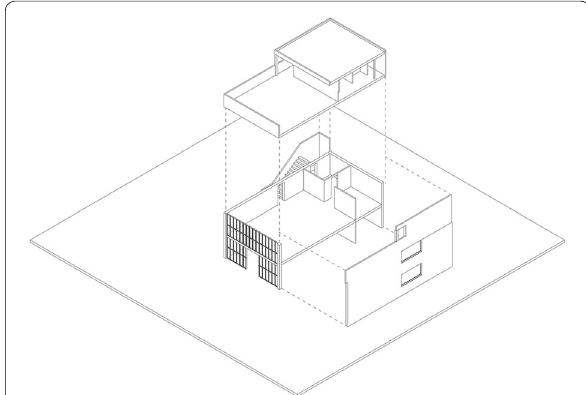
Fig. 2 LeCorbusier’s 1919 Maison Citrohan “sliced” along the horizontal plane. According to LUI, it presents a more rational spatial